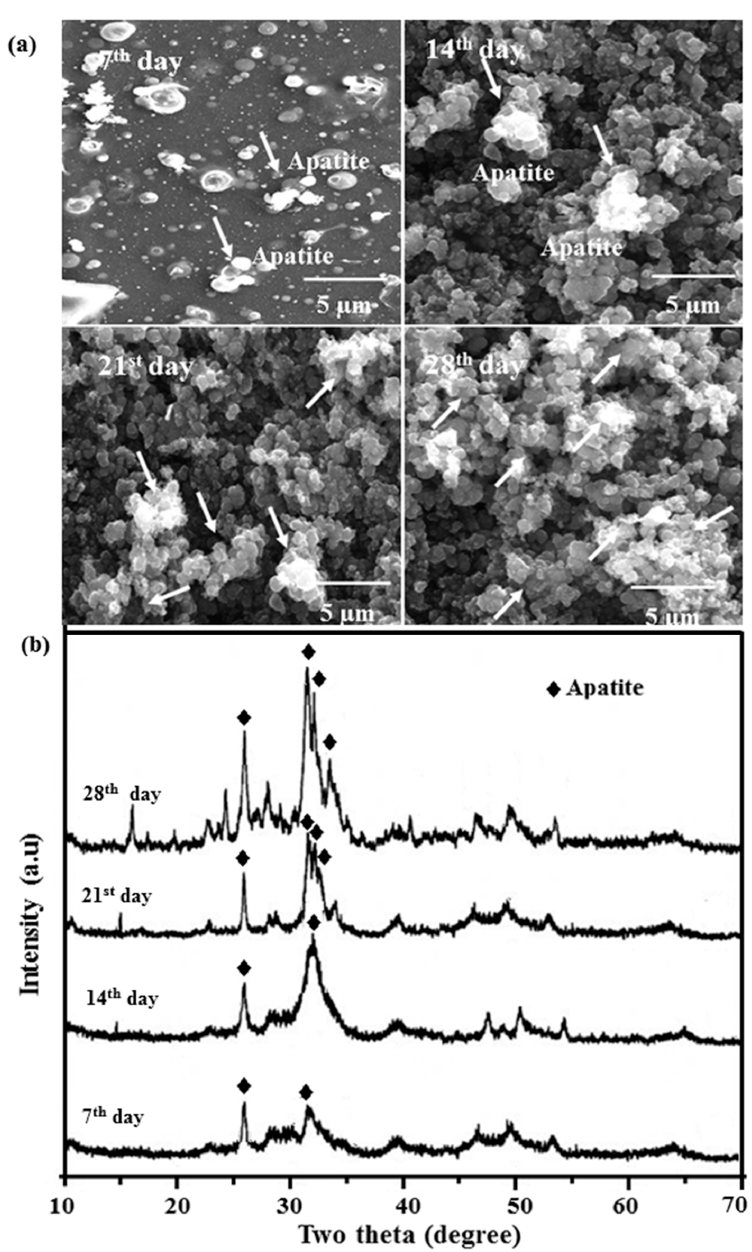
Figure 9. ( a ) FESEM images and ( b ) XRD pattern of Mn-HAp/ZnO bilayer coating on 316L SS at 7, 14, 21 and 28 days of incubation in SBF